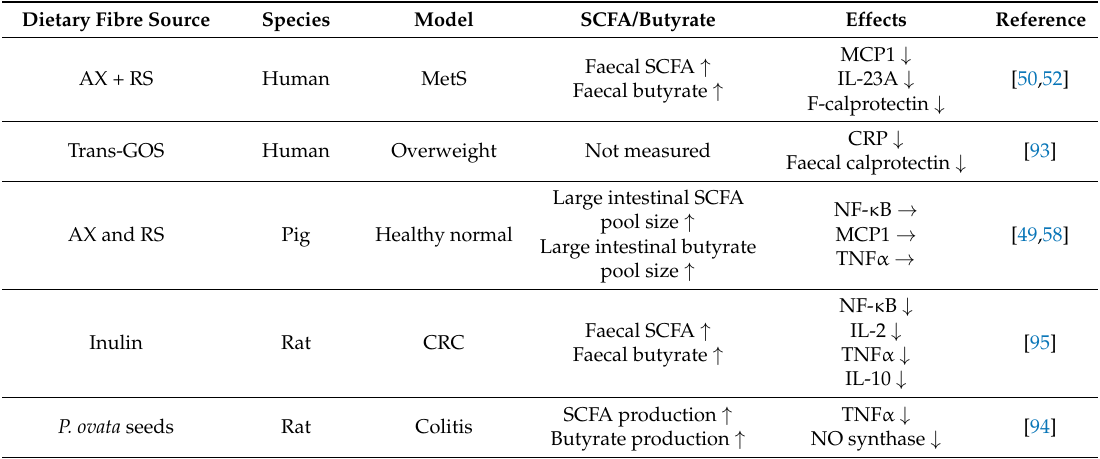
Table 2. Overview of effects of increased short-chain fatty acids and butyrate production and parameters related to intestinal